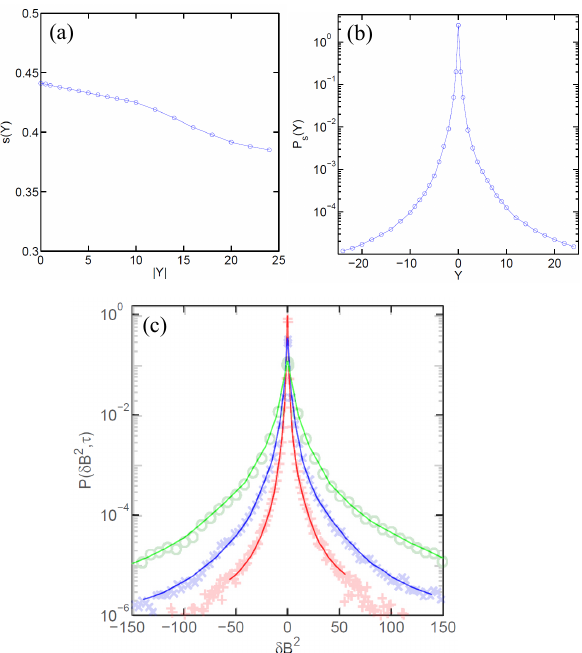
Fig. 12. Fluctuations of B 2 based on solar wind data. (a) and (b) : ROMA spectrum s(Y ) and scaled PDF P s (Y) . (c) : plots of P(δB 2 , τ) : computed PDFs from the ROMA relations with s(Y ) and P s (Y) are shown in solid curves; PDFs from solar wind obser- vations are given by markers. Green (o): τ = 1000s; blue (x): 96s; and red (+): 9s. δB 2 is in the units of (nT) 2 . The PDFs from solar wind data are from Chang et al.